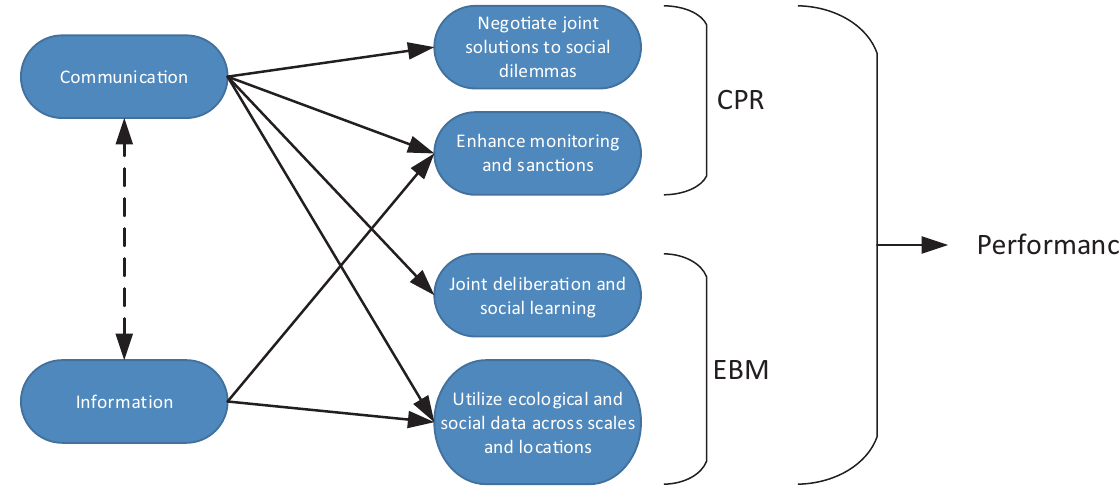
Fig 1. Conceptual description of presumed causal relationships linking communication, and information, to social-ecological outcomes. Communication is assumed to contribute to all four factors, all being assumed to contribute to better social-ecological outcomes (performance). Information, in isolation, is however only assumed to be related to two of these factors. The dashed arrow between communication and information symbolize the potential interaction effect between communication as a venue for disseminating information versus information as such (provided by a neutral and reliable third